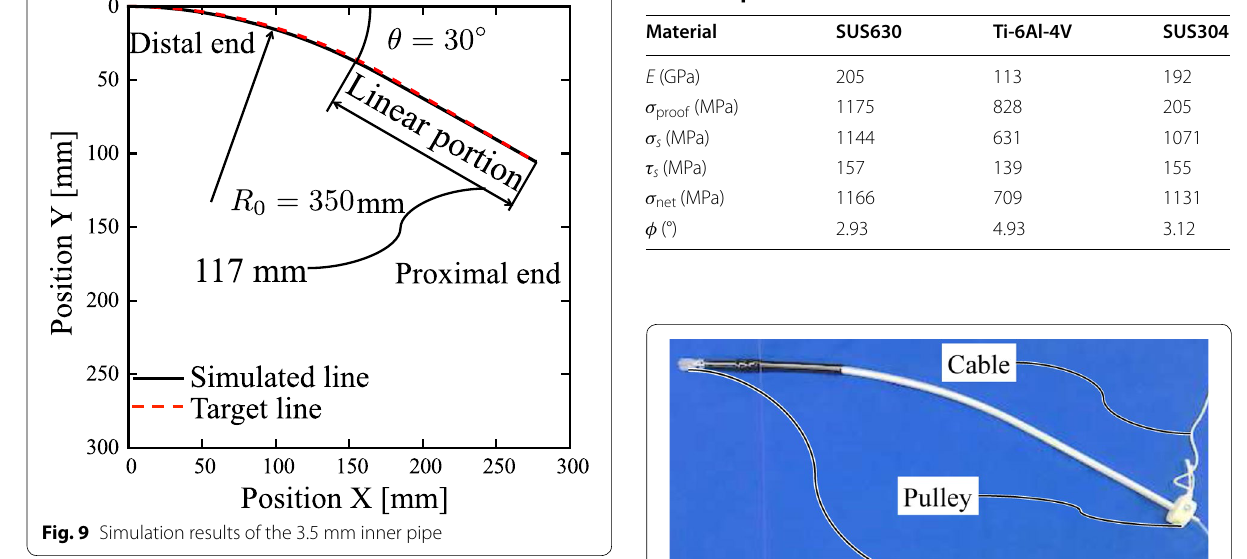
Table 5 Specification of the 5th